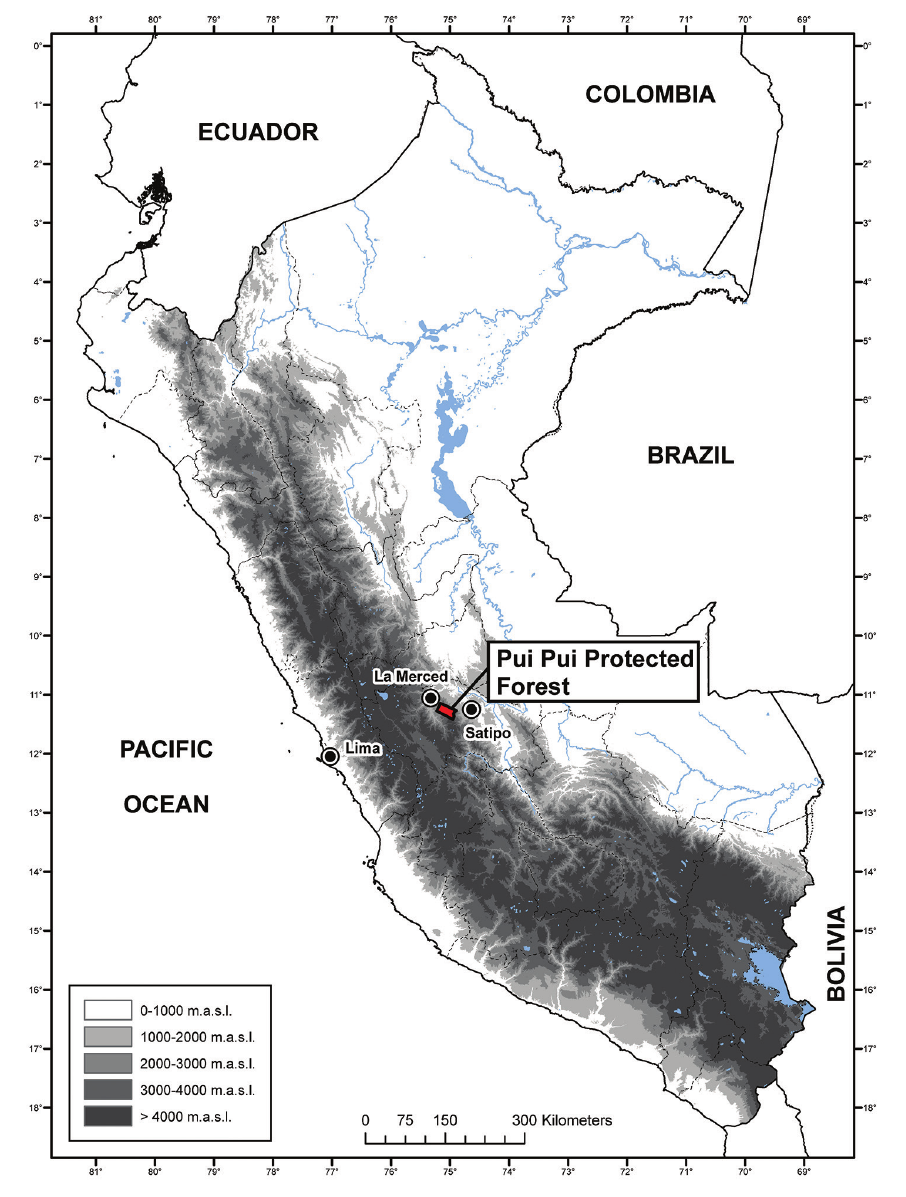
Figure 1. Map of Peru with the Pui Pui Protected Forest indicated in red. Map by J.C. Cusi. in montane forests and puna habitats between 2600 and 4490 m a.s.l. in northern and central Peru (Rodríguez and Catenazzi 2017, Duellman and Lehr 2009). Herein we name and describe this new species of Phrynopus , supported by morphological and phylogenetic evidence, from upper montane forests and puna